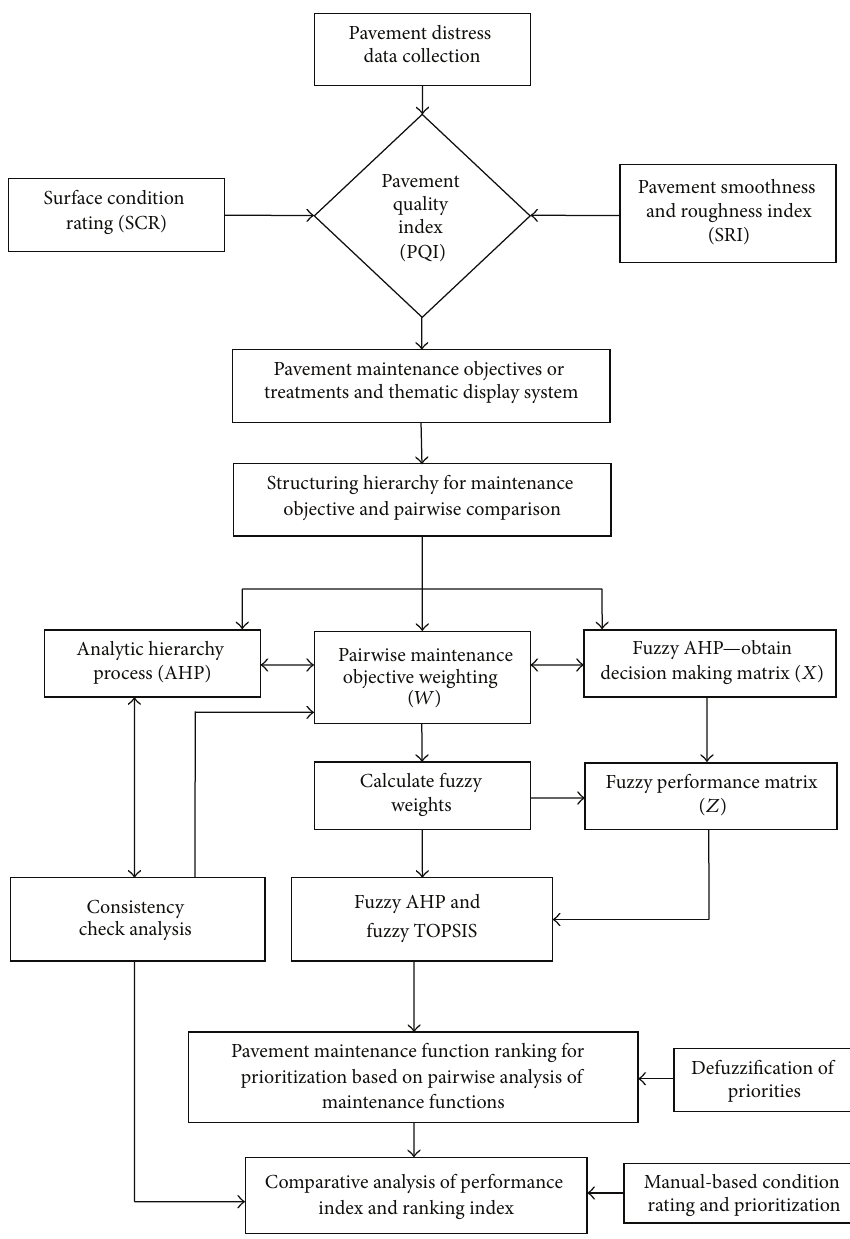
Figure 2: Schematic framework for road pavement prioritization using fuzzy AHP and fuzzy